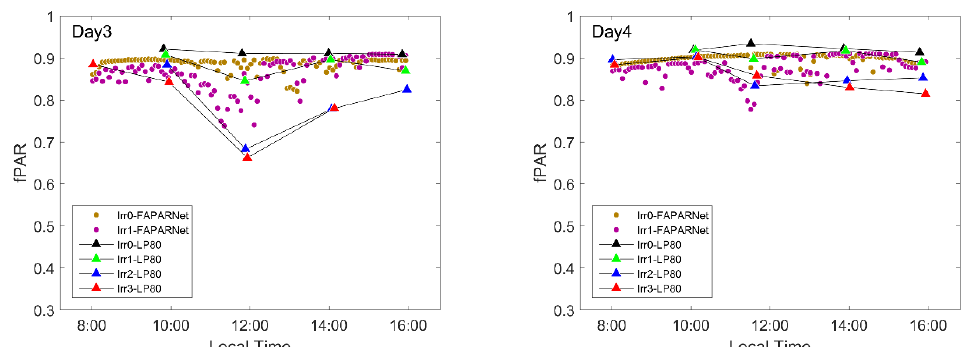
Figure 7. Diurnal variations in absorbed PAR (fPAR) during the experiment, with Day1 to Day4